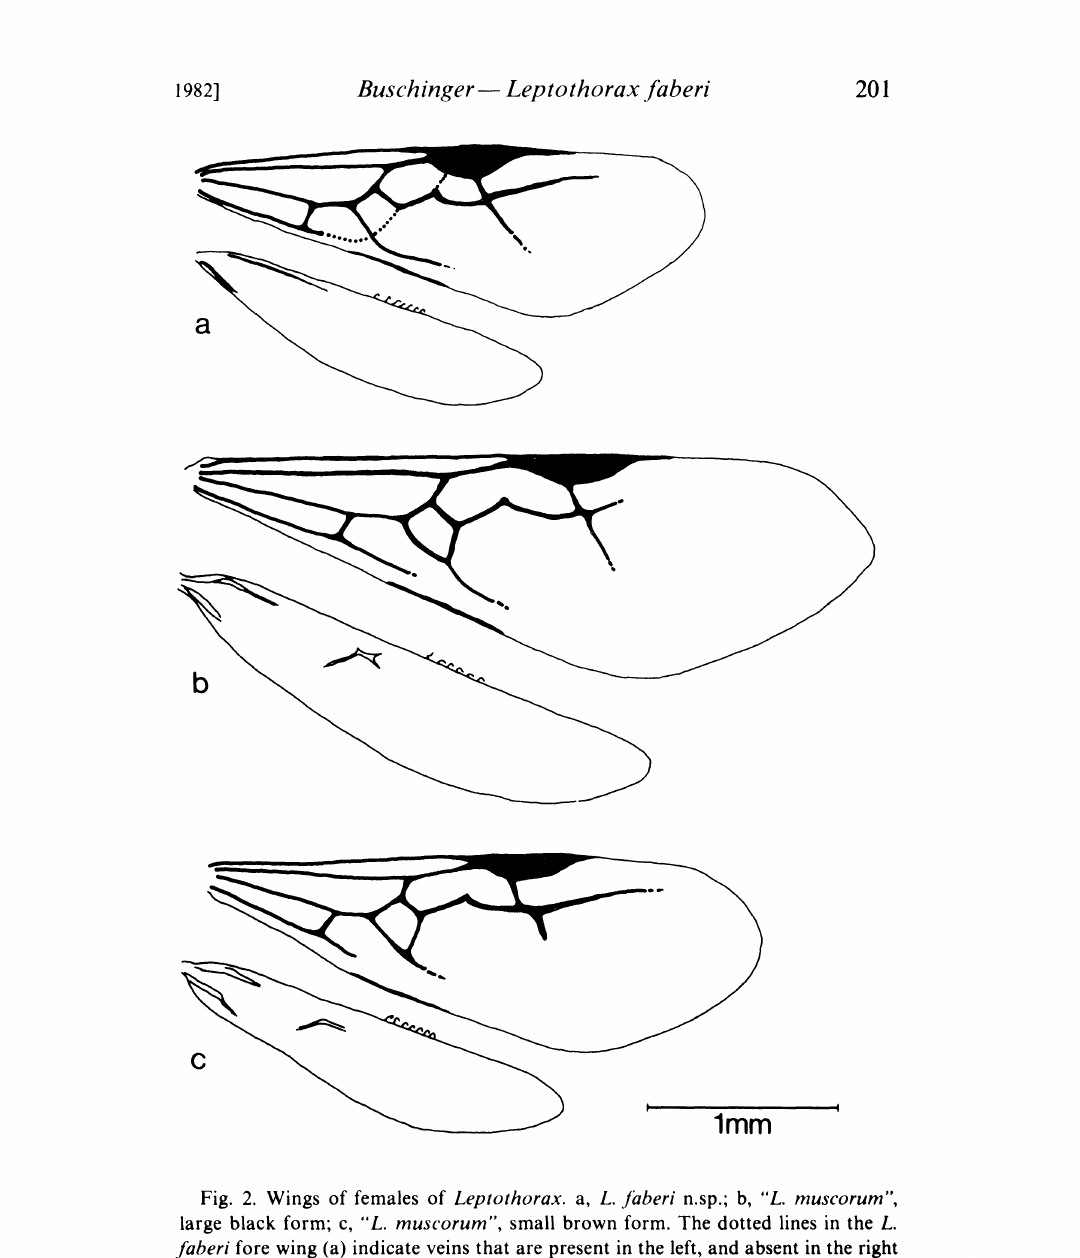
Fig. 2. Wings of females of Leptothorax. a, L. faberi n.sp.; b, "L. muscorum", large black form; c, "L. muscorum", small brown form. The dotted lines in the L. faberi fore wing (a) indicate veins that are present in the left, and absent in the right wing of the same specimen. Wing venation is variable in all species of this